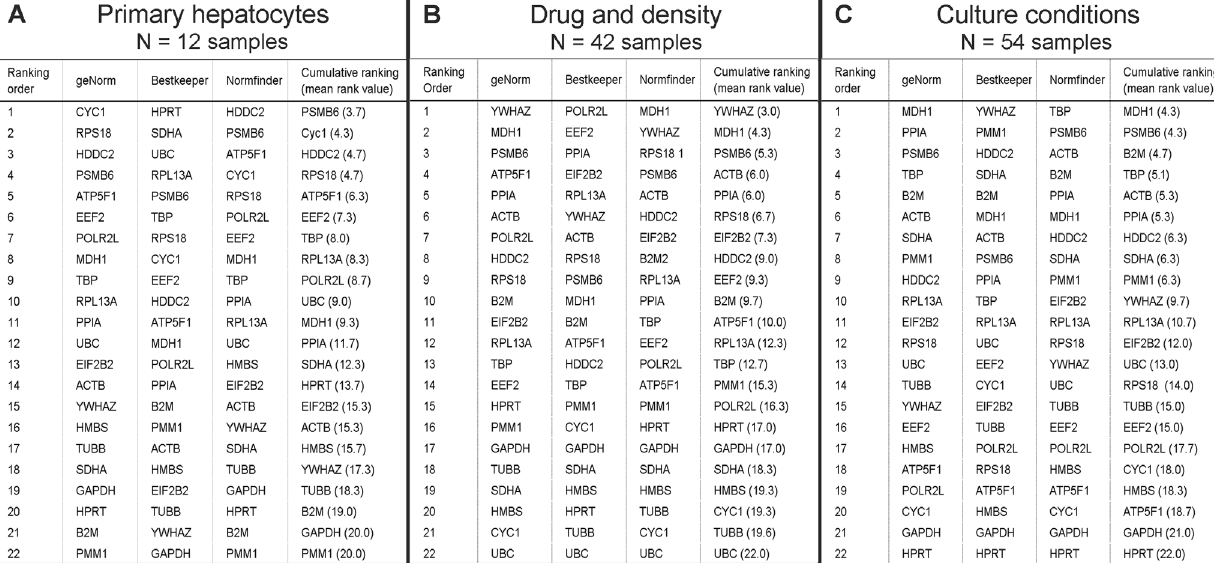
Fig. 2. Reference gene rankings within the subgroups. (A) PH, primary hepatocytes, (B) DD, drug and density and (C) CC, culture conditions (also see Figure 1A, all samples).